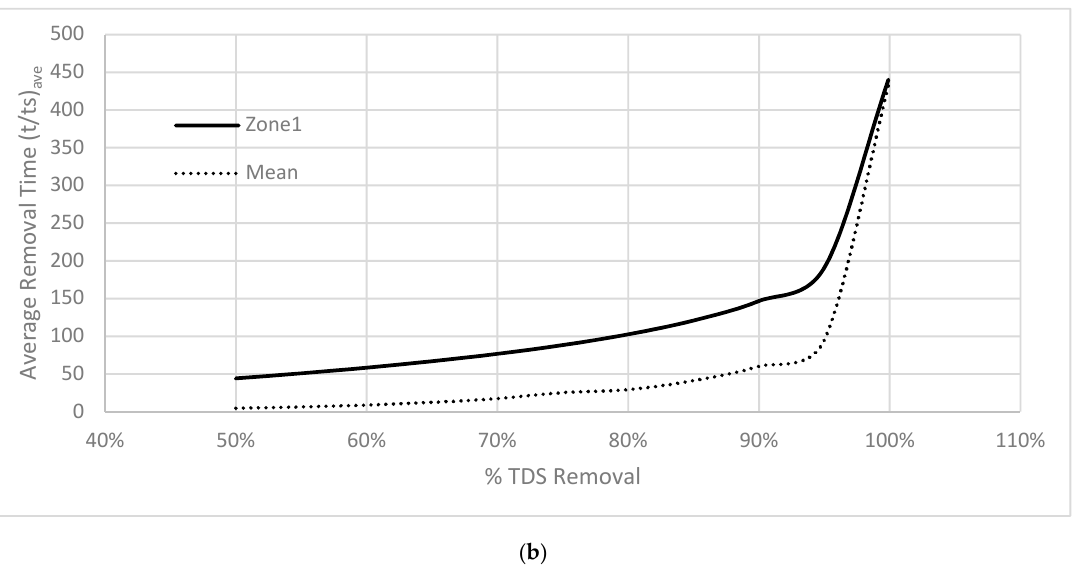
Figure 10. ( a ) Effect of Re and Purging Flow Rate on Time of TDS Removal Ratio (Zone 1, Xp/D = 11) and ( b ) average Time of Removal Ratio for Achieving a Specified % of TDS Removal (Xp/D = 11).